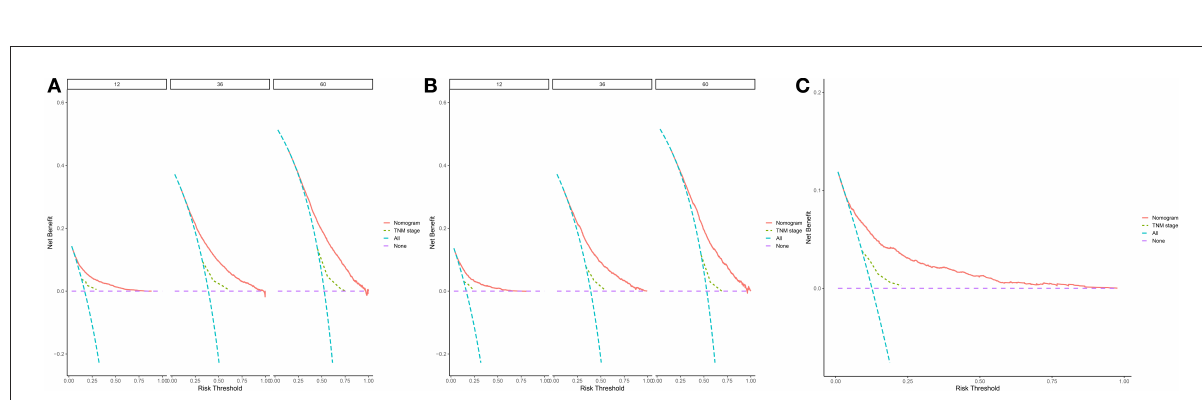
FIGURE5 1-, 3-, and 5-year decision curve analysis of nomogram. (A) The DCA curves of nomogram in training group. (B) The DCA curves of nomogram in internal validation group. (C) The DCA curves of nomogram in external group. The net benefit is shown by the y -axis, and the threshold probability is represented by the x -axis. No patients have died on the purple line, while all patients have died on the blue line. The net benefit of the model exceeds all deaths or no deaths when the threshold probability is between 20 and